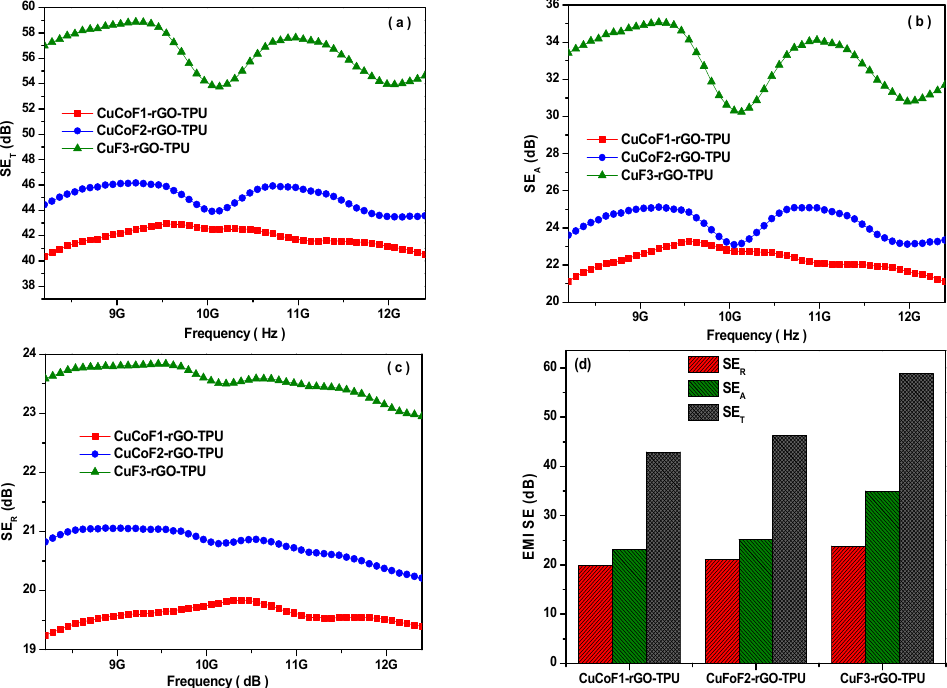
Figure 7. Electromagnetic interference shielding effectiveness ( a ) due to SE T ( b ) SE R ( c ) SE A ( d ) comparison chart of the value of SE R , SE A , and SE T for CuCoF1, CuCoF2, and CuF3 nanoparticles based nanocomposites along with rGO in TPU matrix. Table 1. EMI shielding characteristics of nanocomposites reported in some previous